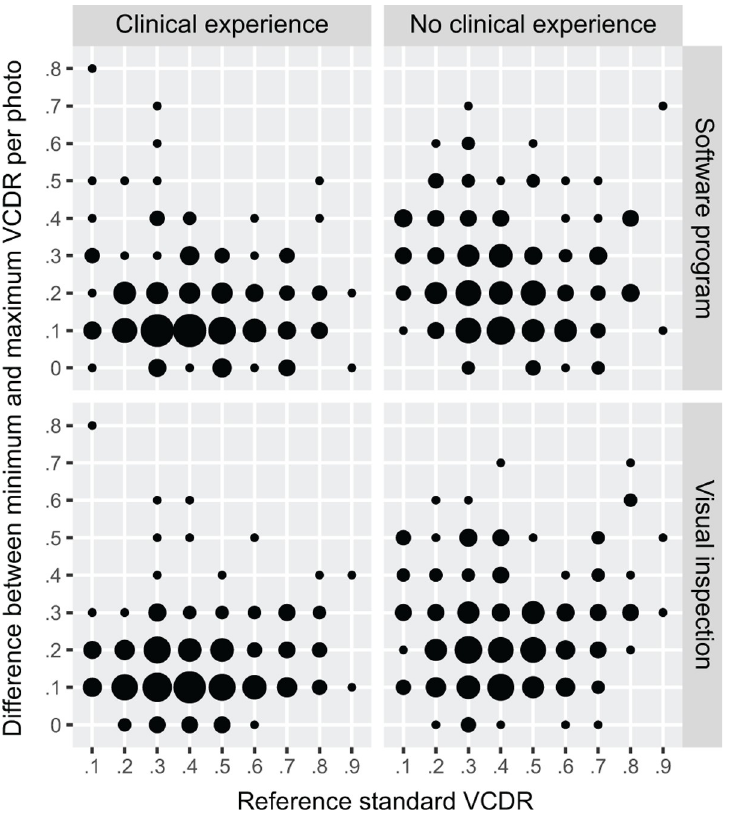
Fig 2. Range of VCDR grades given by non-ophthalmologist graders. The difference between the minimum and maximum VCDR grades given by the non-ophthalmologist graders is plotted against the reference standard VDCR grade. Plots are shown separately for the four graders with clinical experience (left panels) and four graders without clinical experience (right panels), and also for the software-assisted (top panels) and visual inspection (bottom panels) grading techniques. The area of the dots is proportional to the number of